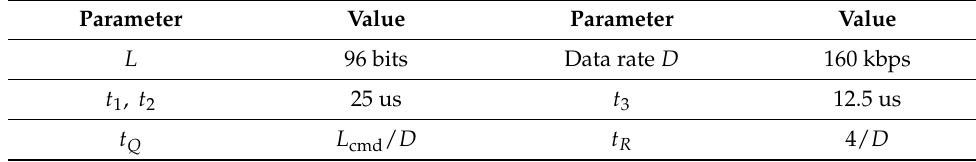
Table 6. Parameters used in simulation.